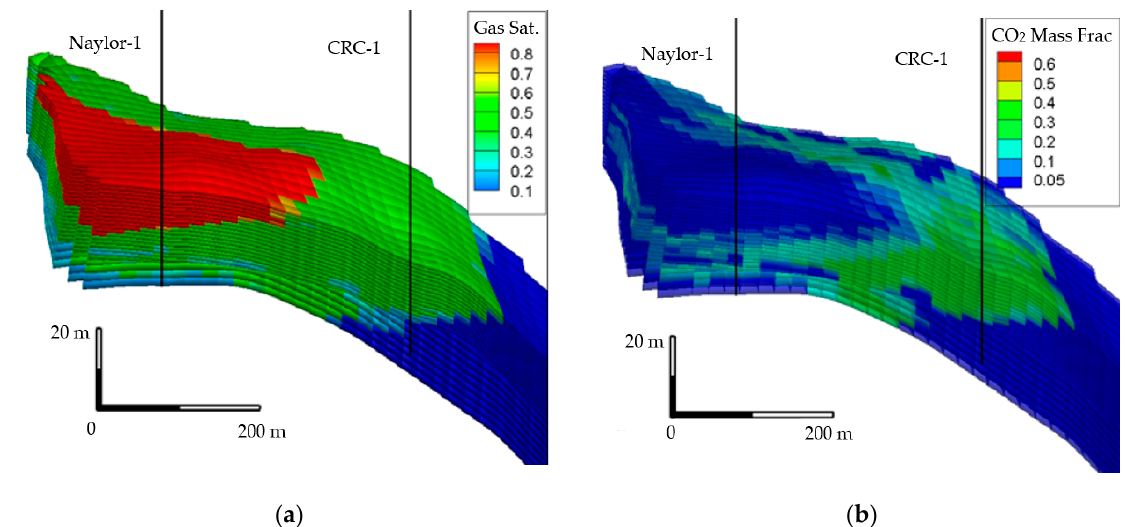
Figure 5. Simulation results of CO 2 injection in the depleted gas reservoir in CMG format ( a )gas saturation distribution; ( b ) CO 2 mass-fraction distribution steps in 3D model modified after [139].